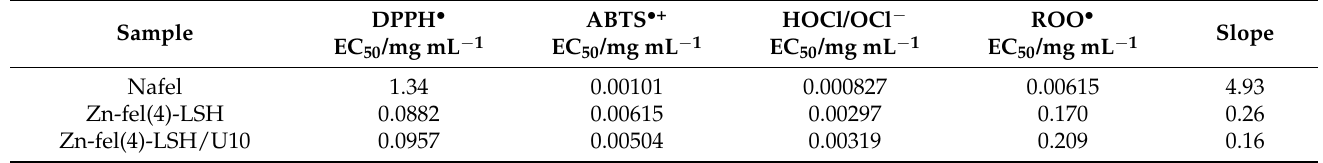
Table 5. DPPH • , ABTS • + , HOCl/OCl − , and ROO • scavenging activities of Nafel (NaC 10 H 9 O 4 ), Zn-fel(4)-LSH and Zn-fel(4)- LSH/U10 samples expressed in the EC 50 values and linear regression slopes for the V 0 /V versus [Antioxidant]/[Crocin]